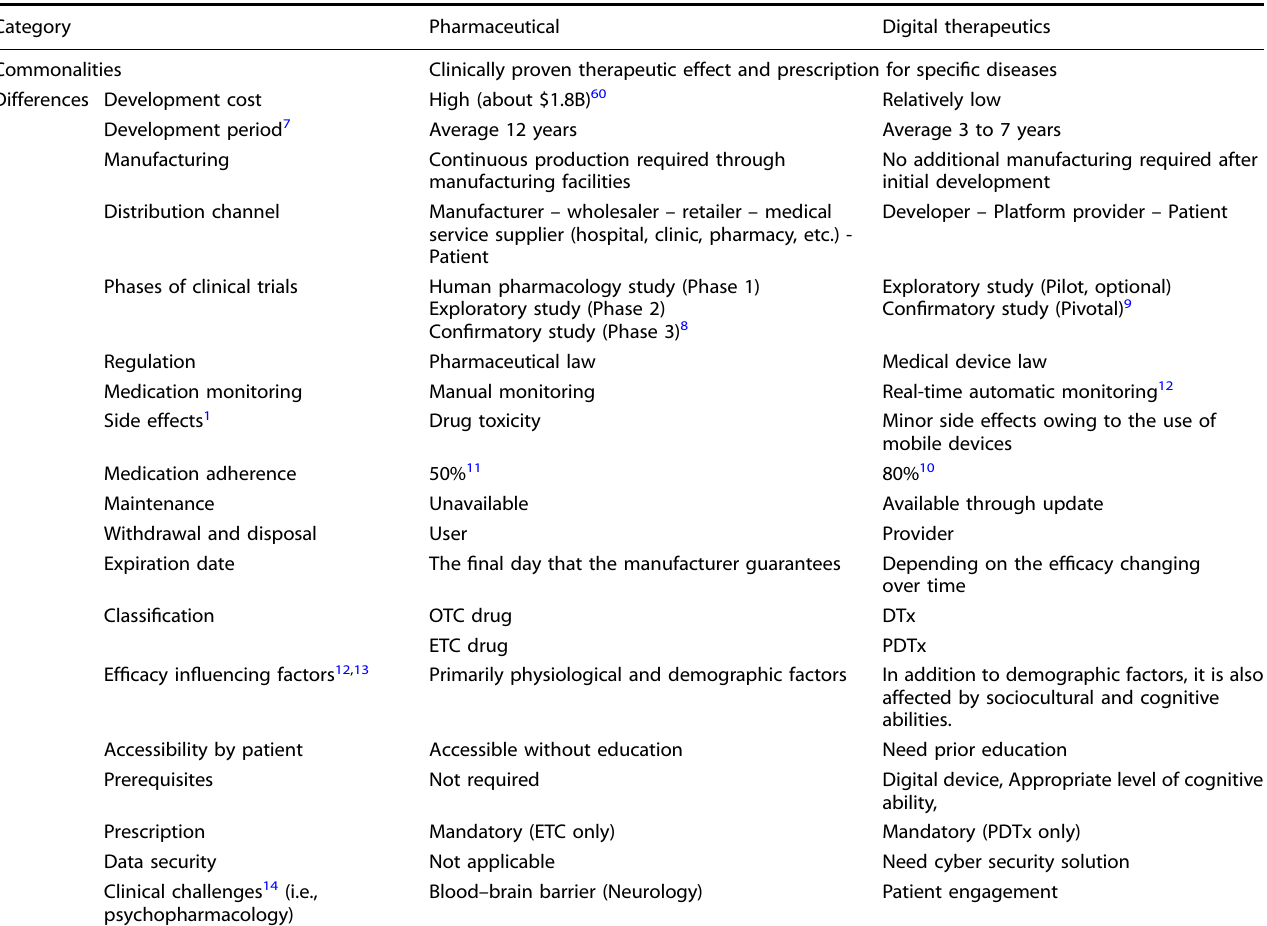
Table 2. Comparison between conventional pharmacotherapy and digital